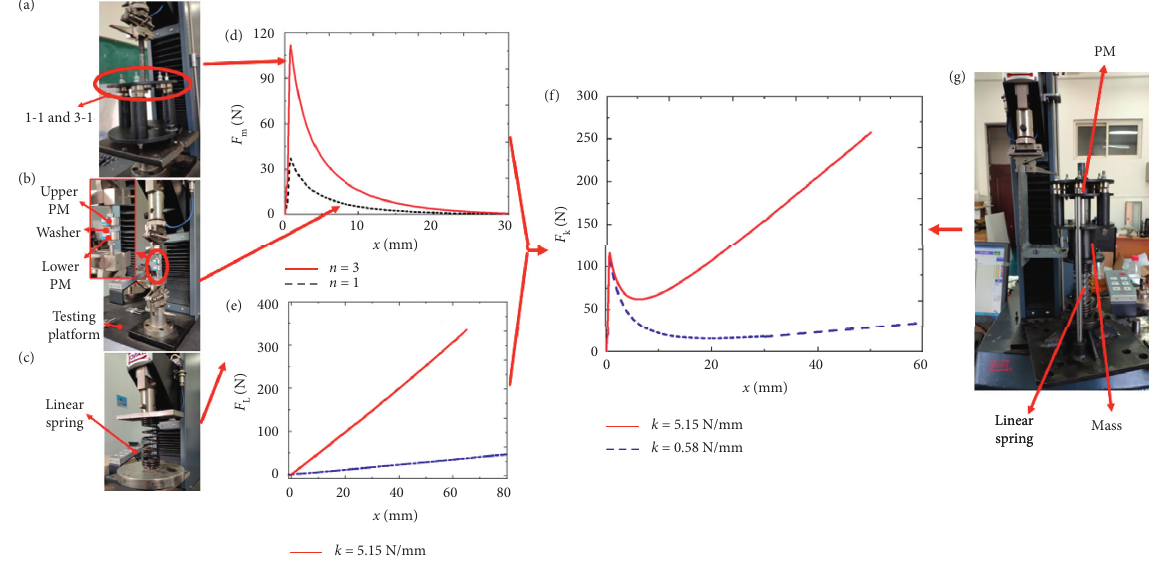
Figure 14: The SRS of the different systems. (a) Ω � 100. (b) Ω � 30. (c) Ω � 20.